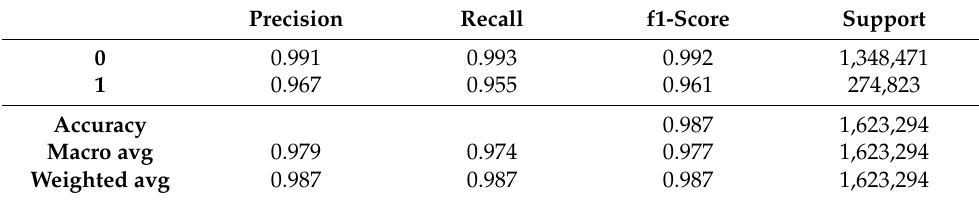
Figure 4. The loss-time graph with a best average error of random forest of − 0.9810 and the finite loss range of − 0.9810, − 0.9751, and − 0.9805. Table 6. Classification report of model before using random forest model.